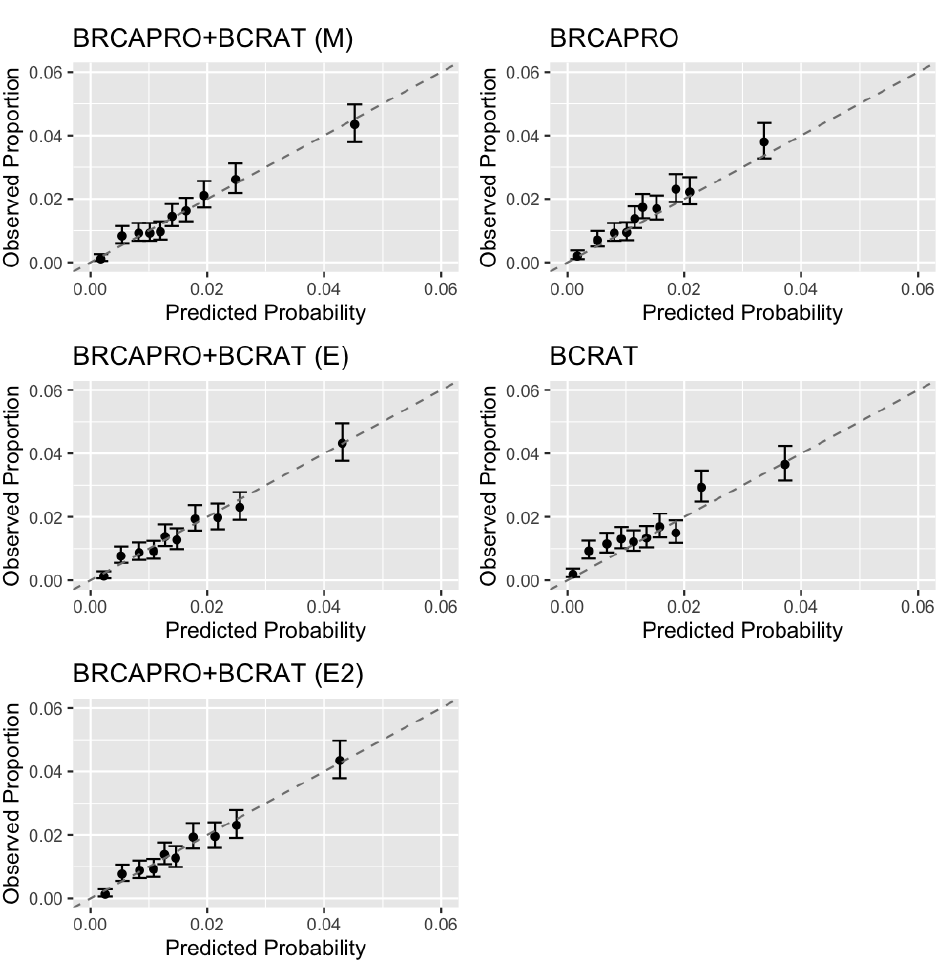
Figure 2. Calibration plots by decile of risk for five-year predictions in a simulated dataset with 45,557 counselees (724 cases). For each model, we grouped individuals by decile of risk and plotted the observed proportion of women who developed cancer (with 95% Wilson CI) versus the predicted probability (sum of risk predictions) within each